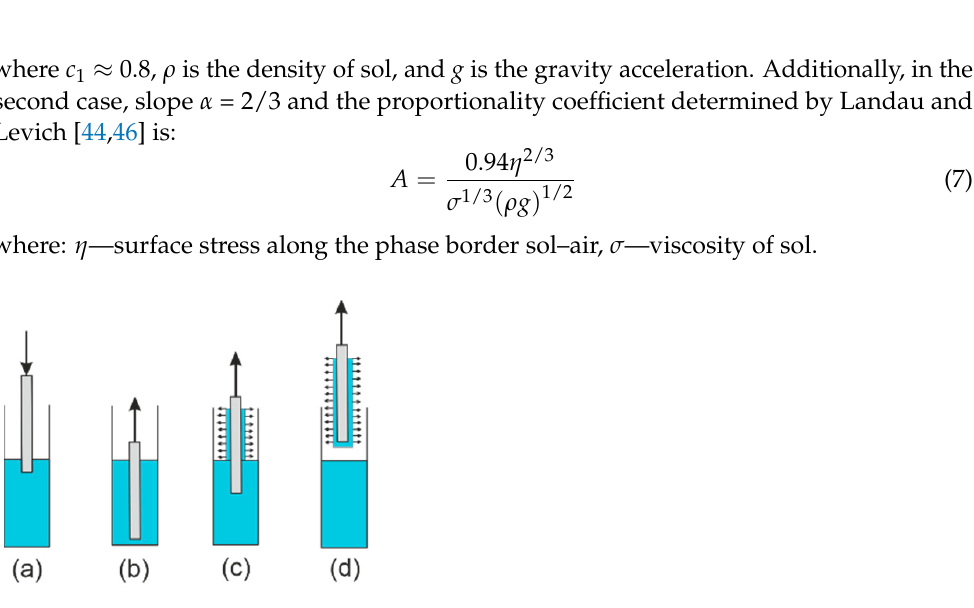
where c 1 ≈ 0.8, ρ is the density of sol, and g is the gravity acceleration. Additionally, in the second case, slope α = 2/3 and the proportionality coefficient determined by Landau and